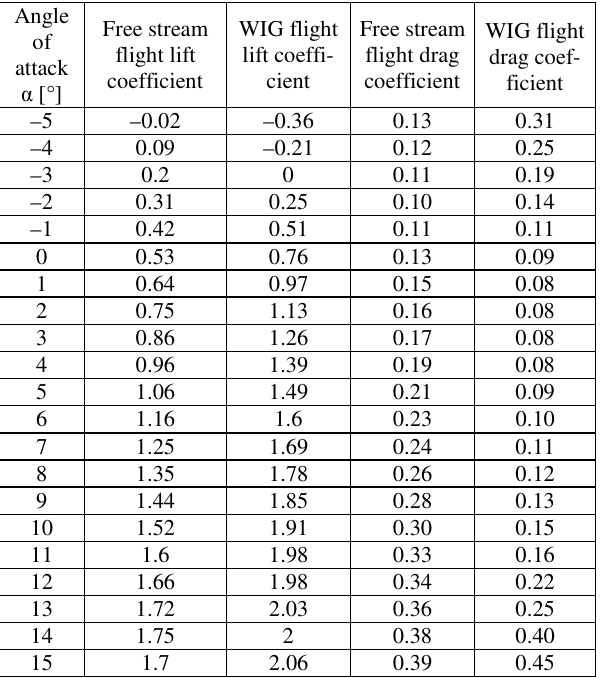
Table 1. Lift and drag coefficient values for NACA M8 profile [4]